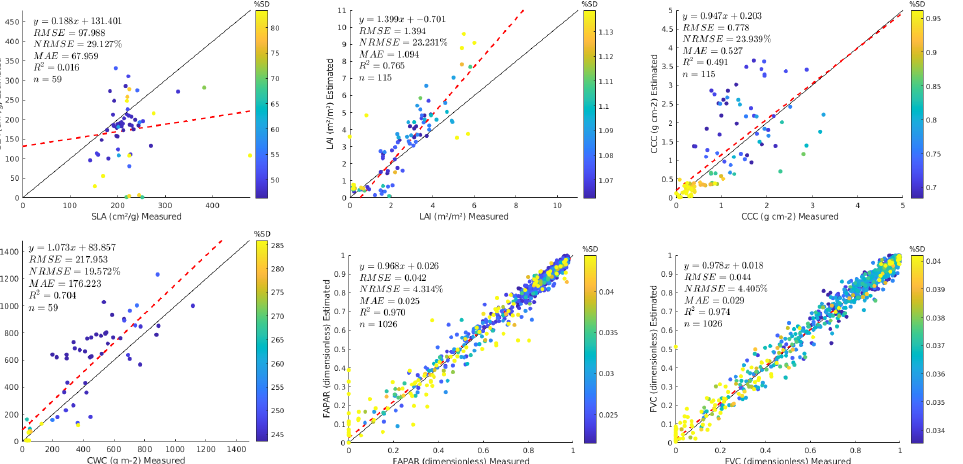
Figure 6. Scatter plots displaying the GPR-20BR model results against the Grosseto and MNI in situ measurements, with goodness-of-fit statistics. In the case of FAPAR and FVC, theoretical results are provided. The colors of points represent the standard deviation (SD) obtained by the GPR